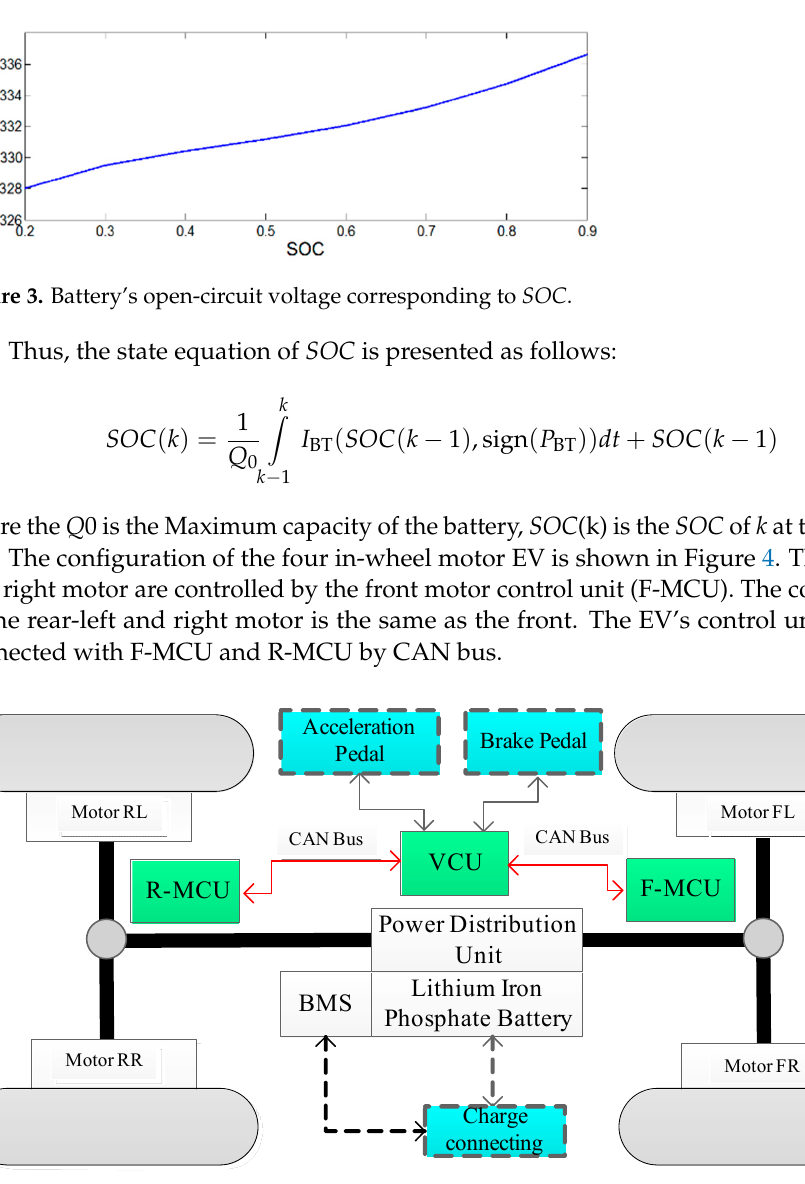
Figure 4. Configuration of PHEV test platform distribution. There are three driving forms in driving mode, front driving mode, rear driving mode, and coupling operation of front and rear drive mode, respectively. Thus,